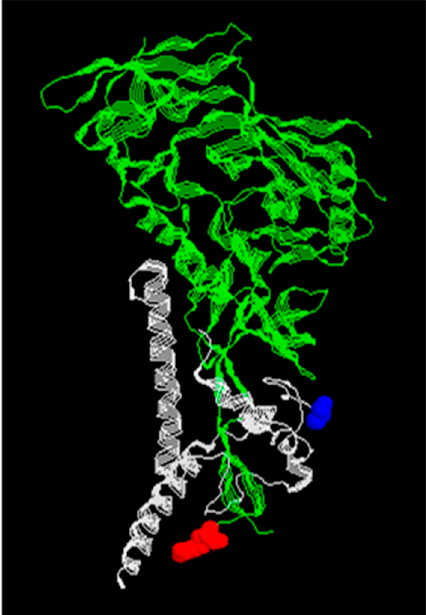
Figure 2. X-ray crystal structure of the HIV-1 envelope pg160 glycoprotein monomer. The fusion machine is composed of three gp160 monomers which are divided into N-terminal gp120 (green) and C-terminal pg41 (gray). Residue in red denotes the end of gp120 and residue in blue the beginning of gp41 after PC cleavage. PDB ID code 6MTJ.